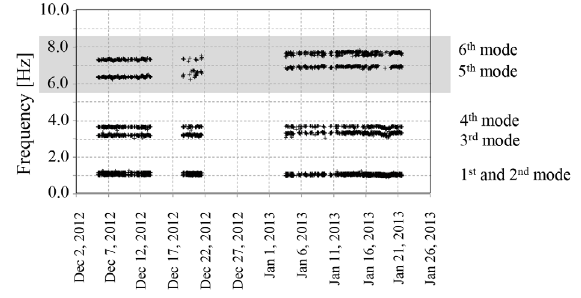
Figure 7. Evolution of the first six natural frequencies over the mo- nitoring